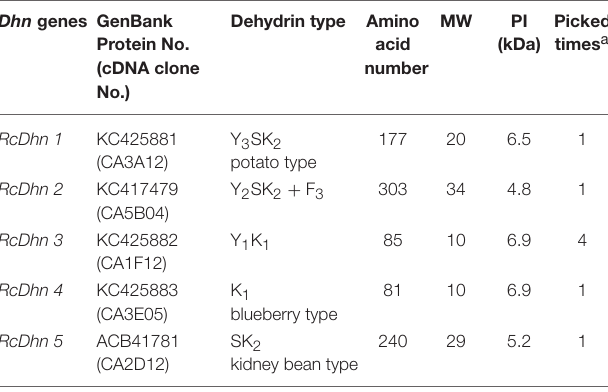
TABLE 2 | Characteristics of Rhododendron Dhn genes and their protein products. Dhn genes GenBank Protein